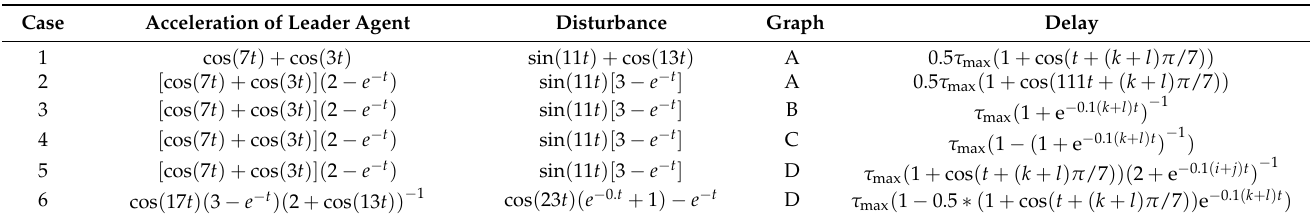
Table 2. Acceleration of leader agent, disturbance, and delay used for performance